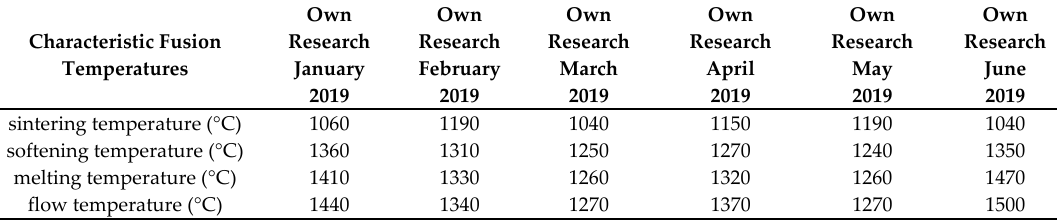
Table 2. Parameters of characteristic fusion temperatures of ashes from cow dung